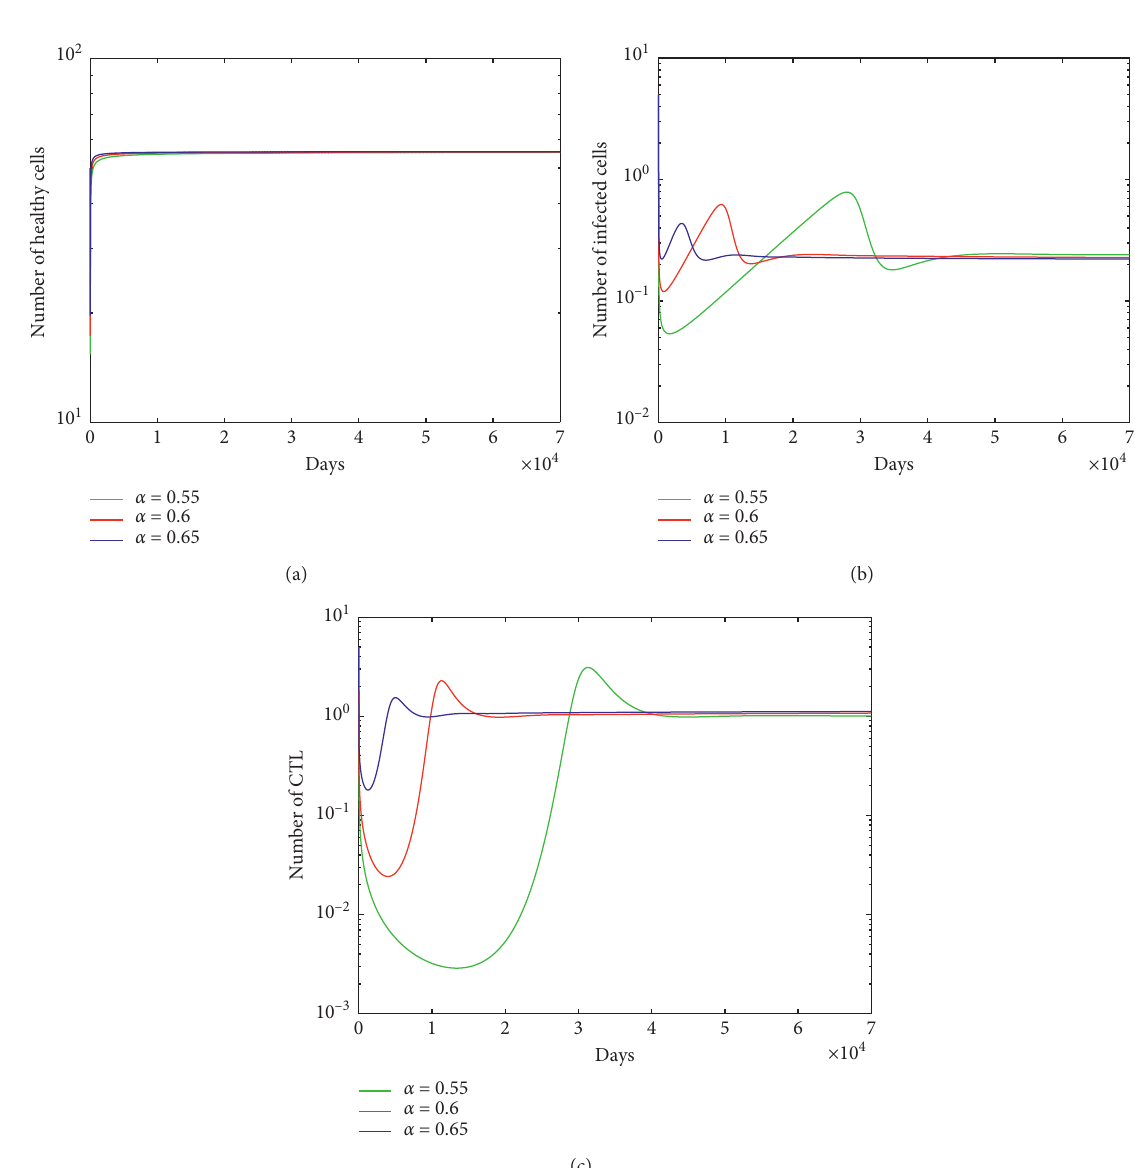
Figure 1: Simulation results of immune-response equilibrium E